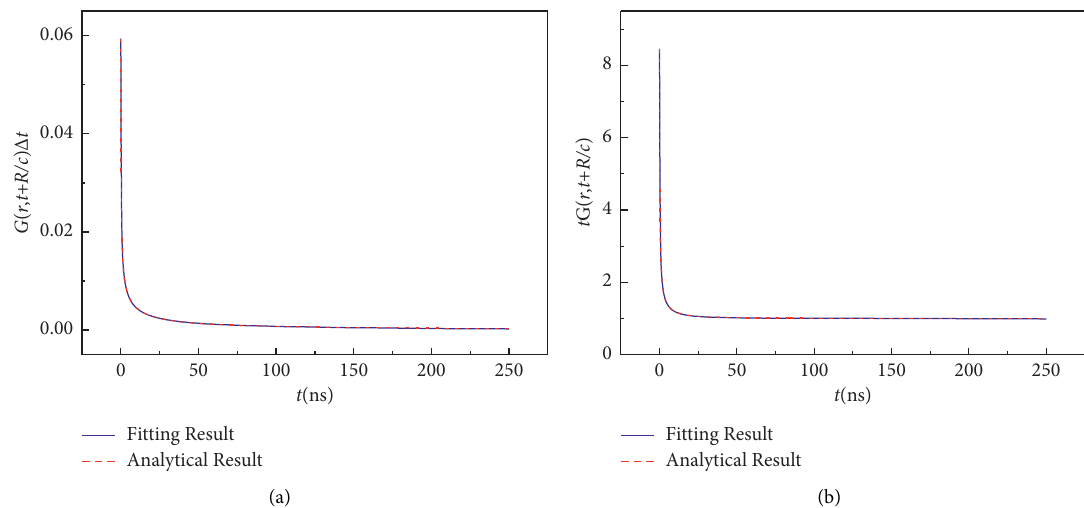
Figure 2: Comparison of the fitting results by the Prony’s approximation with the analytical results. (a) Convolution kernel 1. (b) Convolution kernel 2.